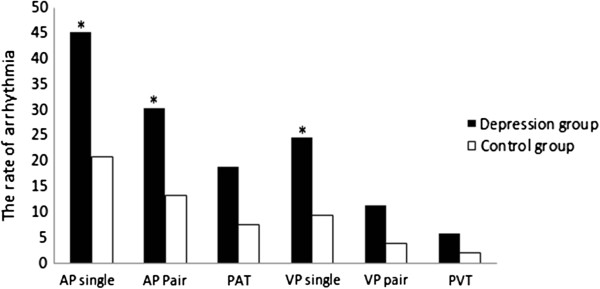
Comparison the rates of arrhythmia between the depression and control group. Note: Chi-square test, compared to control group, *P<.05.